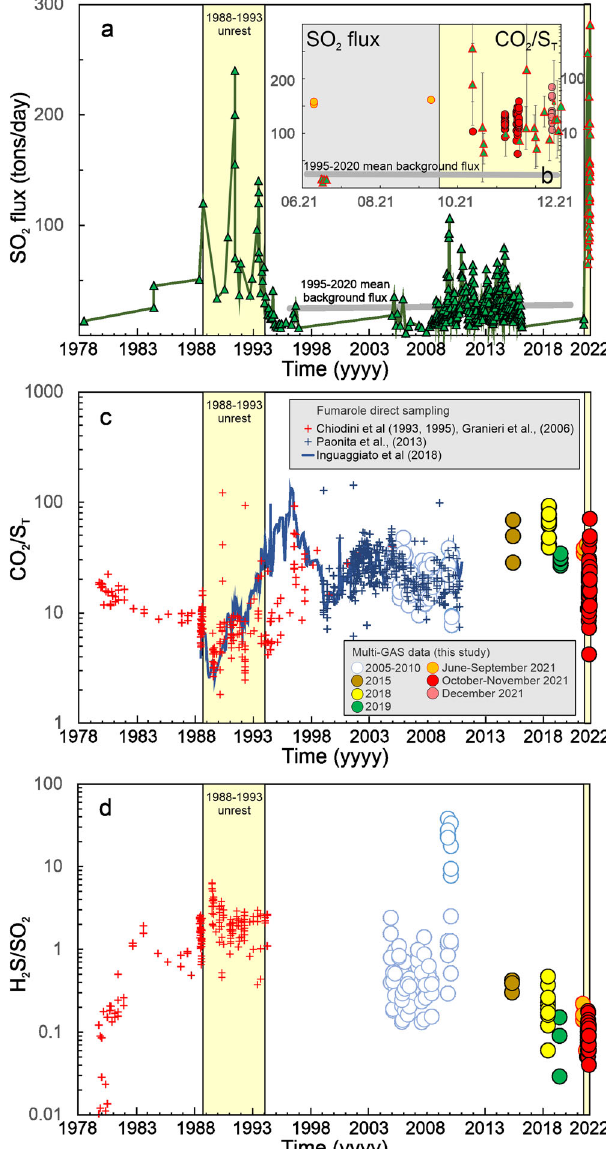
Fig. 2 Temporal record of gas fl ux and fumarole composition from La Fossa crater. a SO 2 fl uxes from La Fossa. Green triangles are literature data 37,49 – 52,97,117 – 120 . Our 2021 results (Supplementary Table 1) are shown as red-bordered green triangles. The time-averaged 1995 – 2020 fl ux is taken as representative of background degassing. b A magni fi ed section of the time series (June-December 2021) shown in ( a ), showing the acceleration in SO 2 degassing since October 2021. The error bars correspond to 1 standard deviation of the daily averaged fl ux. The Multi- GAS derived CO 2 /S T ratios of panel ( c ) are also shown (as circles); ( c ) Temporal record of fumarole molar CO 2 /S T ratios. Notably, the SO 2 fl ux refers to the bulk (total) plume, while the reported gas compositions are for individual fumaroles. We integrate results from direct sampling of the fumaroles (red crosses, refs. 19,36,40 ; solid blue line, ref. 34 ; blue crosses, ref. 23 ) and from Multi-GAS sensing of near vent plumes (open circles, 2005 – 2010 results 55,96,97,118 – 120 ; 2015 – 2021 are from this study, Supplementary Table 2); d Temporal record molar H 2 S/SO 2 ratios in fumarole emissions (same sources as panel c ).